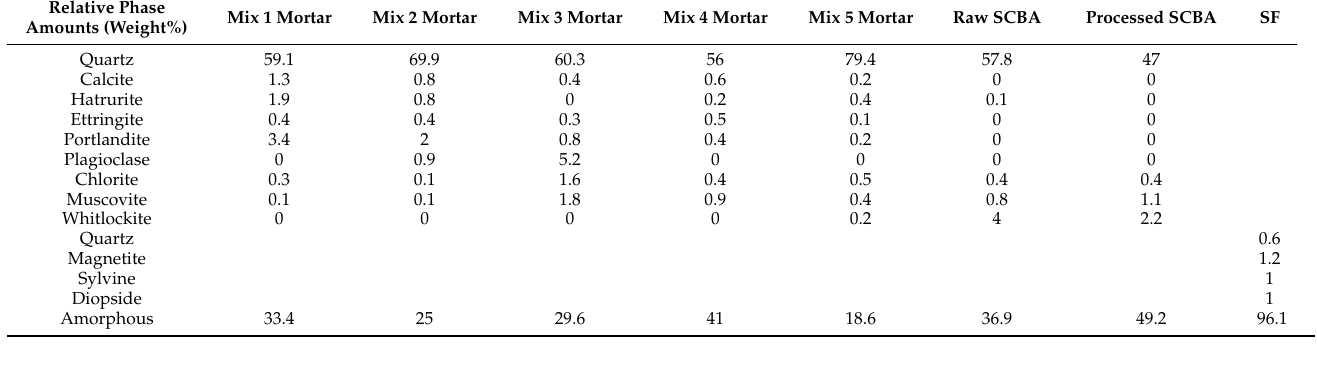
Table 4. Relative Phase amounts (weight%).